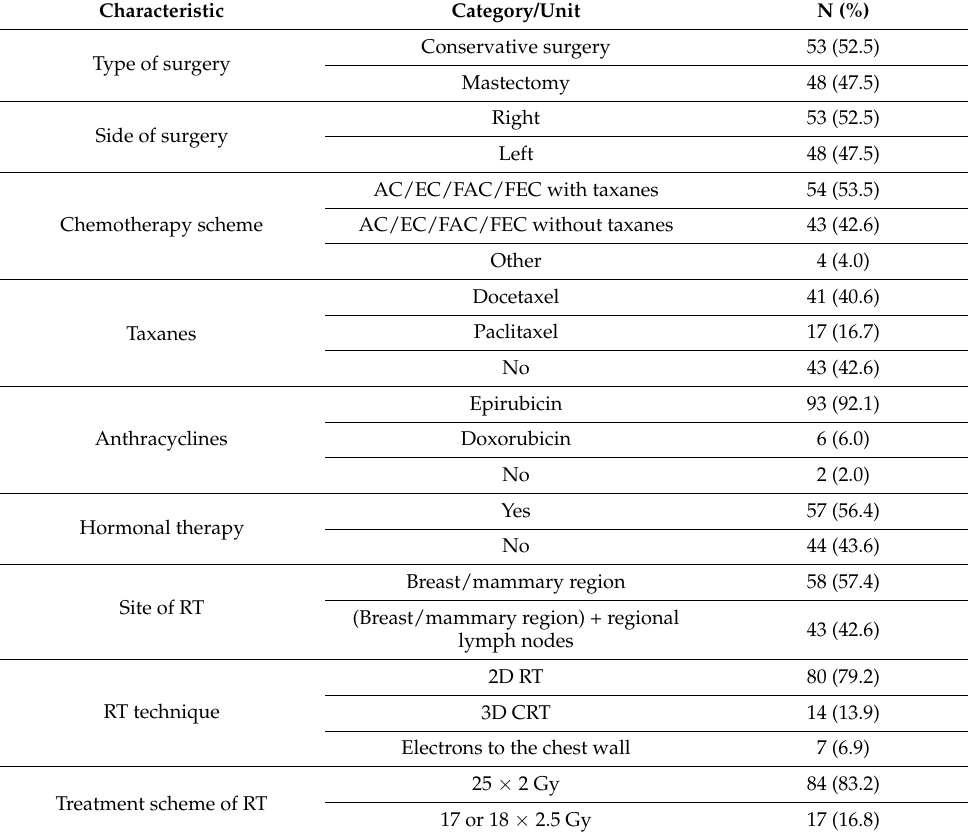
Table 2. Treatment parameters of breast cancer patients included in the study (N =